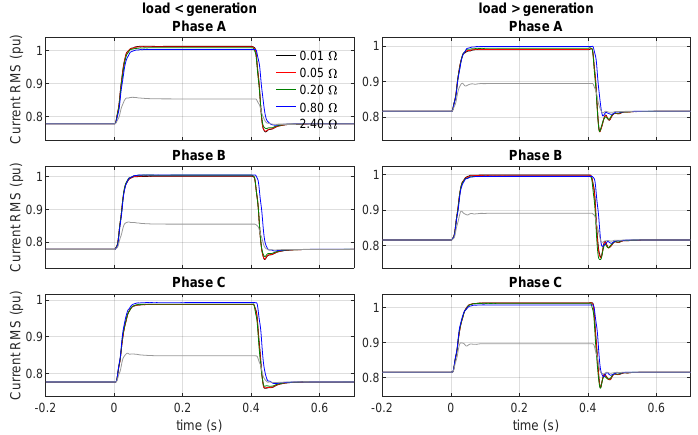
Figure 20. Phase currents at ST’s MV Inverter (AC side) following unbalanced phase–phase faults in the HV AC grid for the considered fault resistances.